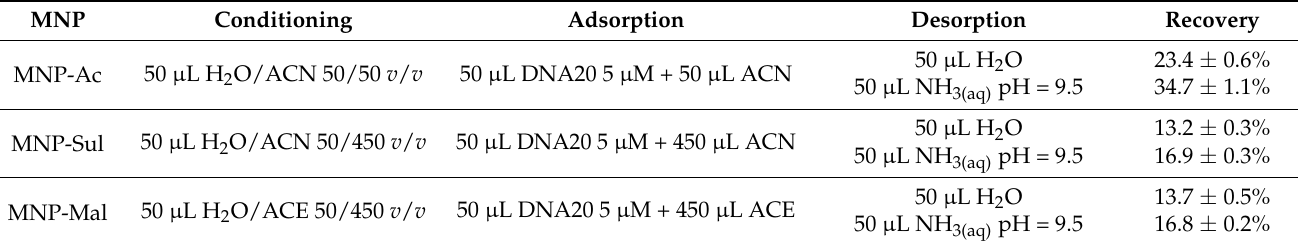
Table 3. The conditions used for the extraction of DNA-20 in the HI mode. Abbreviations: MNP—magnetic nanoparticles; ACN—acetonitrile;